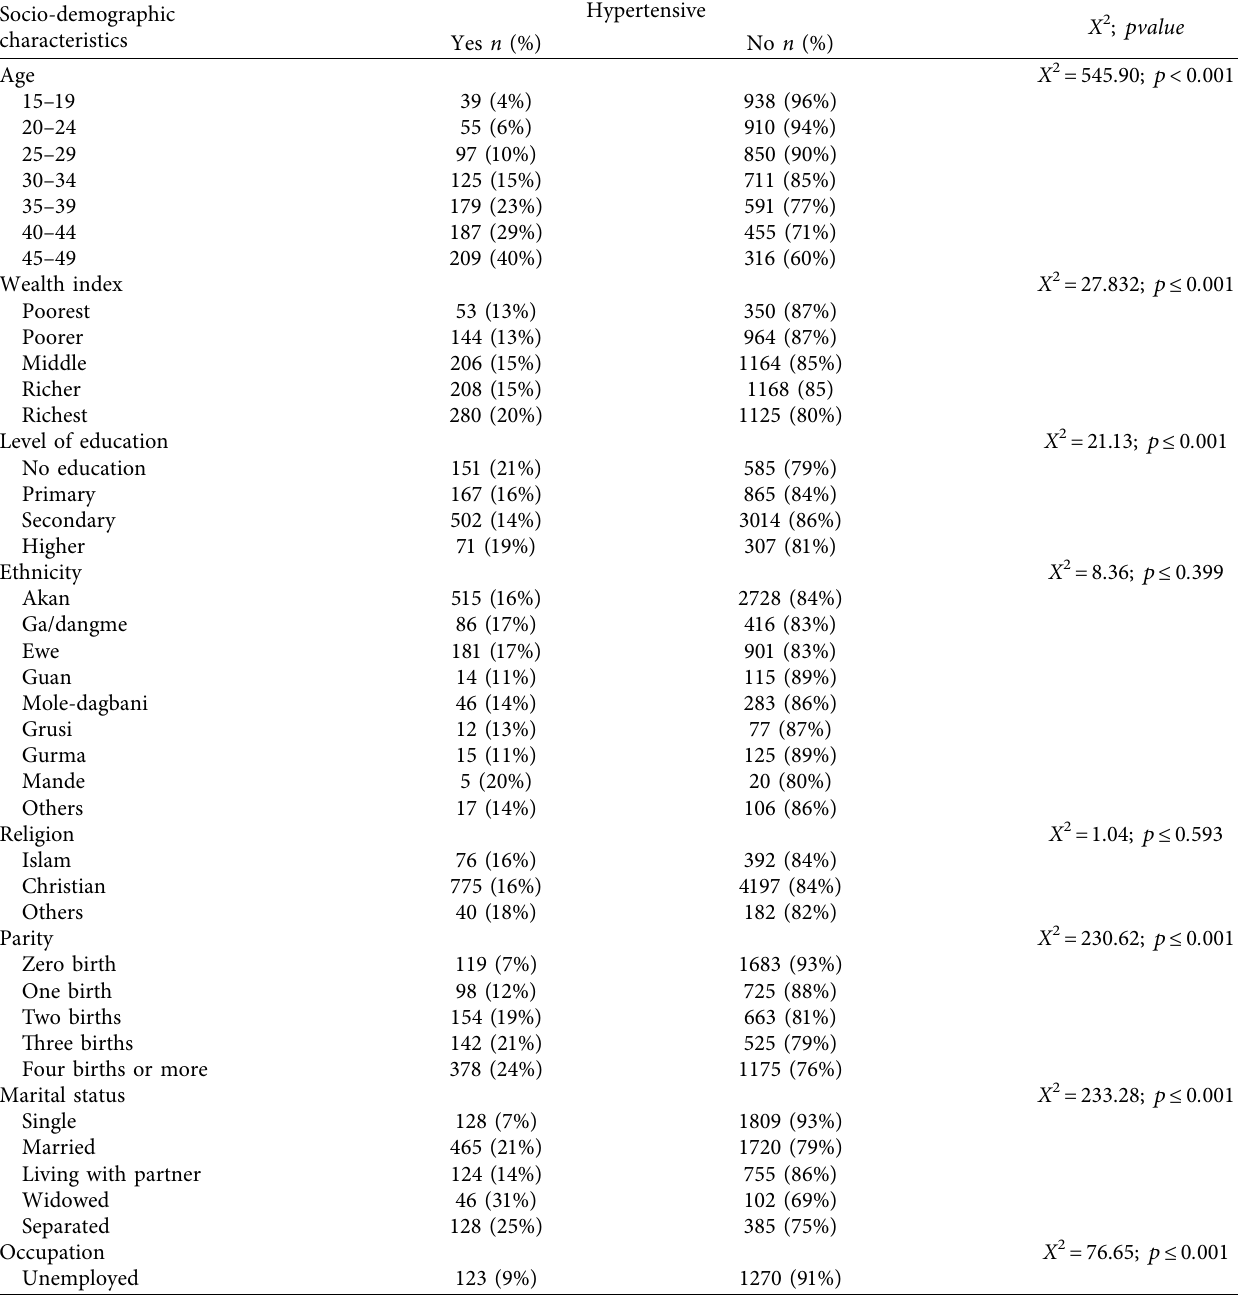
Table 2: Hypertension prevalence by socio-demographic